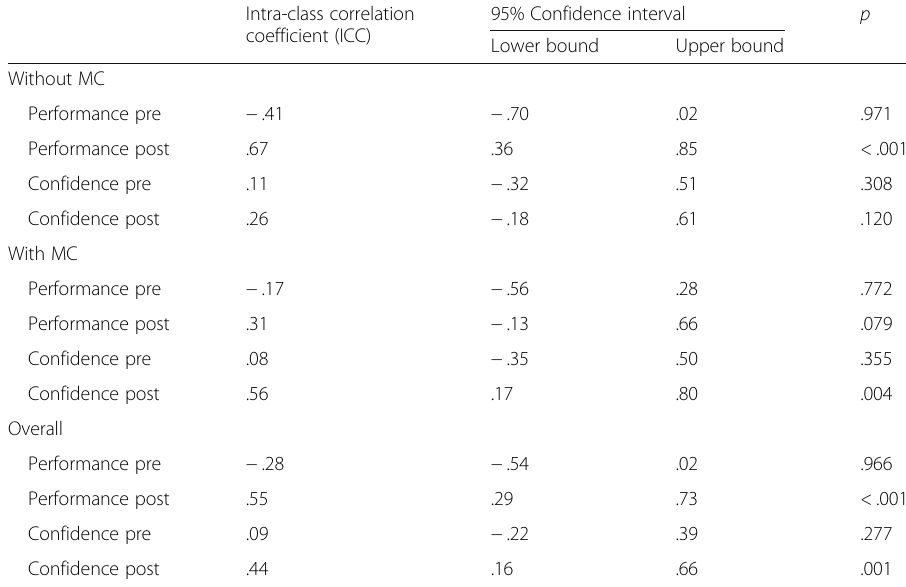
Table 3 Intra-class correlation coefficients per group and outcome variable Intra-class correlation 95% Confidence interval p coefficient (ICC) Lower bound Upper bound